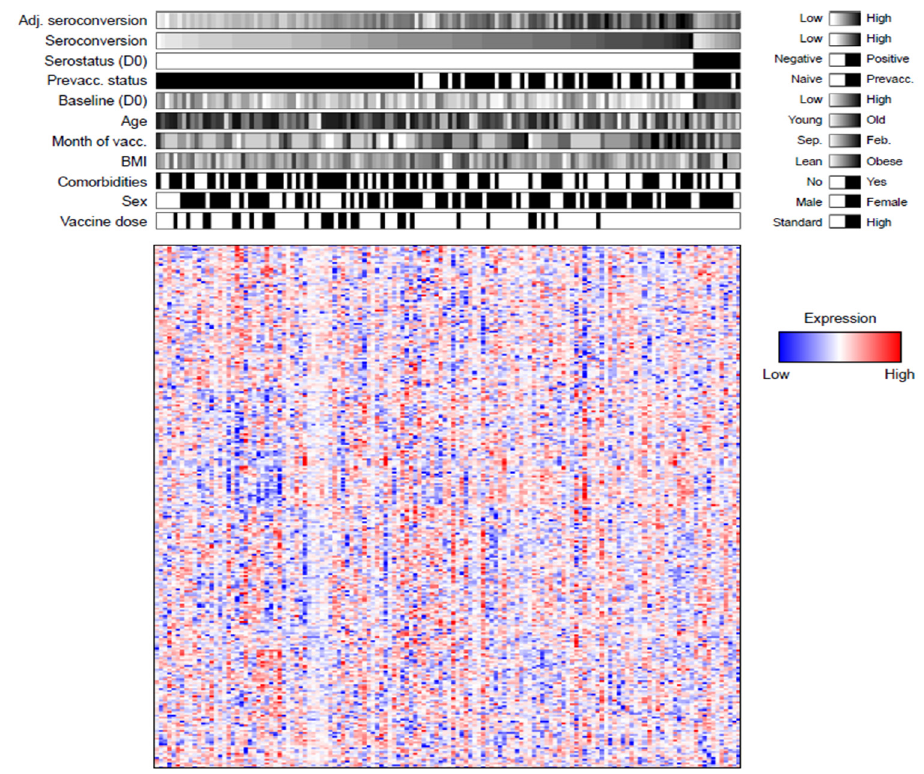
Figure 1. Protein levels of 273 proteins across recipients of the split-inactivated influenza vaccine.